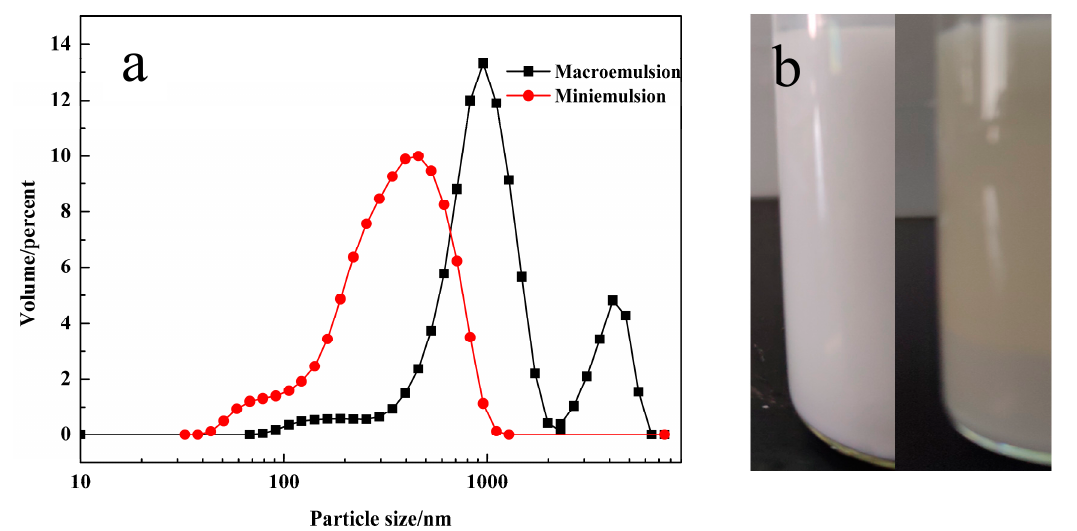
Figure 2. ( a ) Particle size distributions of macroemulsion and miniemulsion. ( b ) Photographs of macroemulsion just after ultrasound and after 3 h of rest (left and right, respectively).